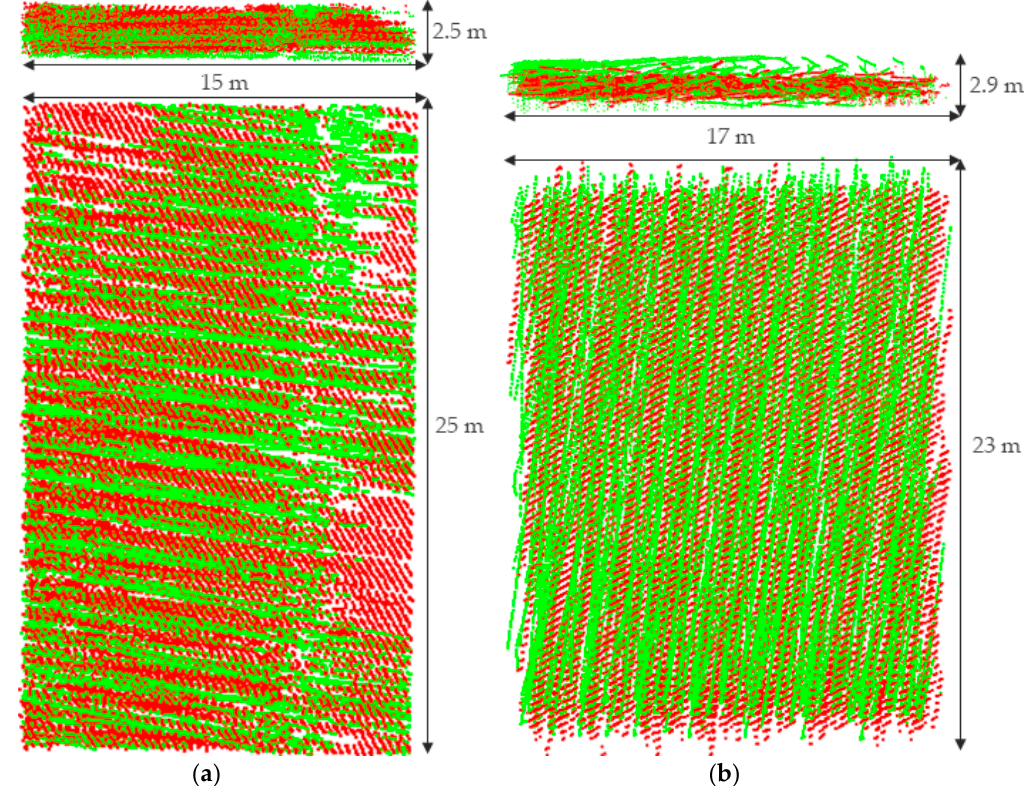
Figure 7. Planes used to calculate the RMSE, where green is Strip 3, and red is Strip 6: ( a ) plane ⑦ with 73,619 points; ( b ) plane ⑨ with 54,758 points.